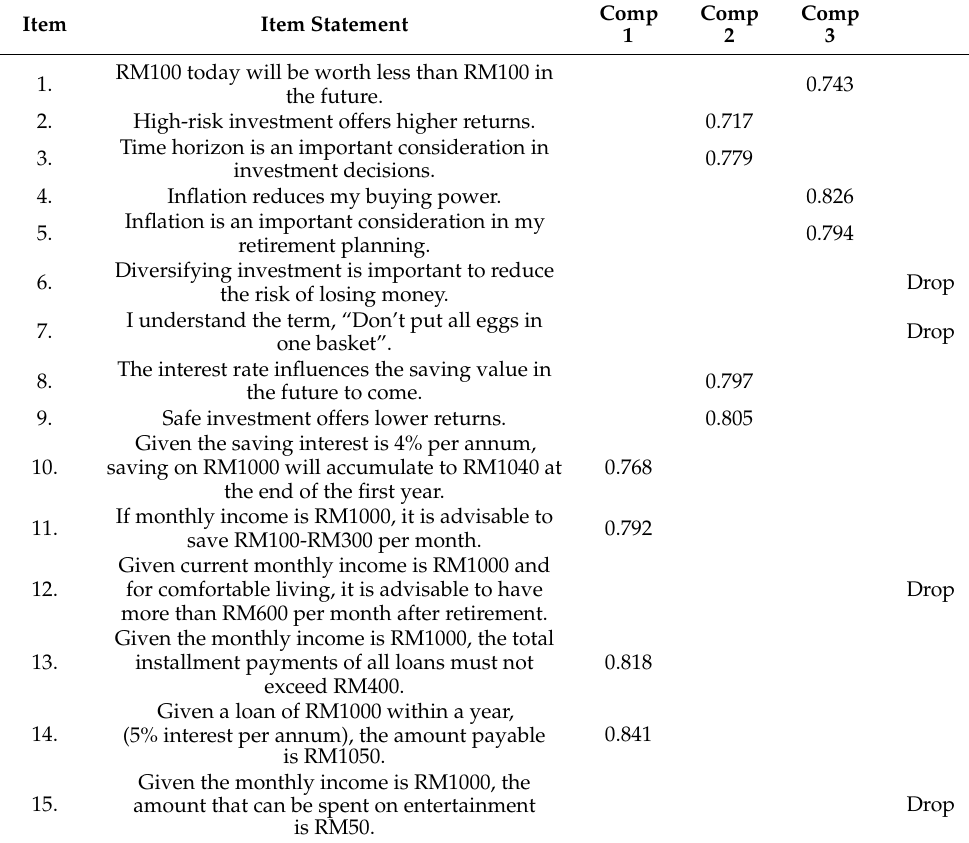
Table 1. Rotated Component Matrix of Financial Literacy Construct.